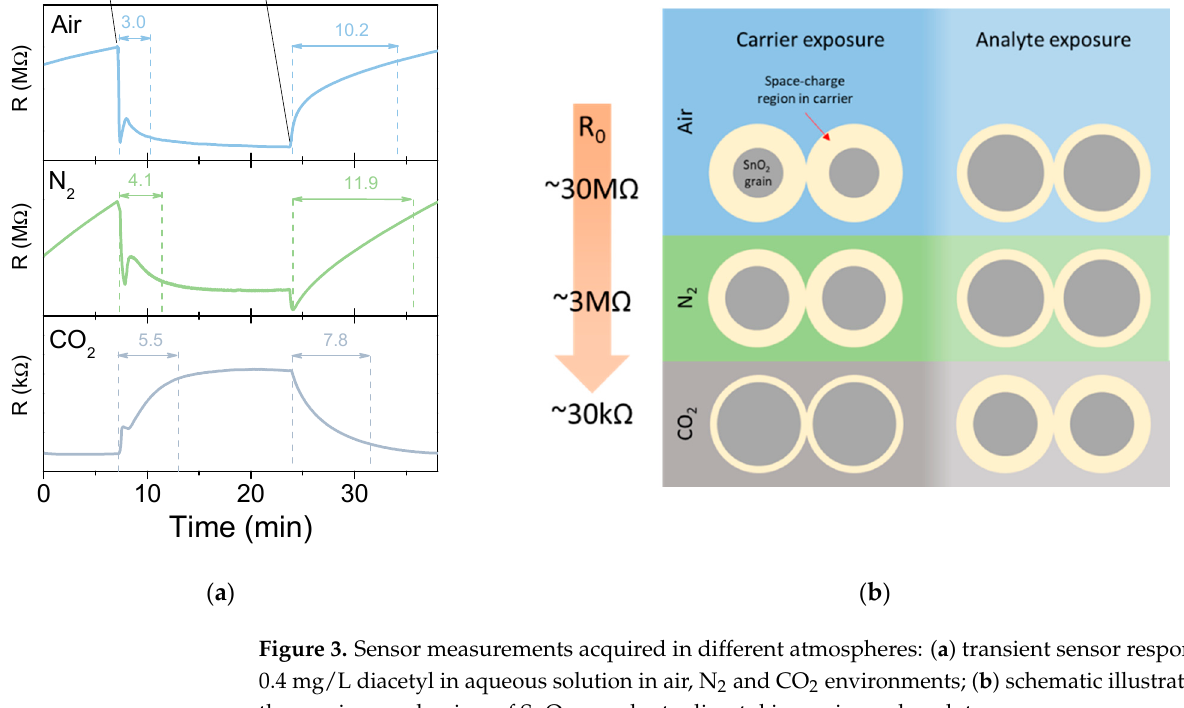
Figure 3. Sensor measurements acquired in different atmospheres: ( a ) transient sensor response of 0.4 mg/L diacetyl in aqueous solution in air, N 2 and CO 2 environments; ( b ) schematic illustration of the sensing mechanism of SnO 2 powder to diacetyl in carrier and analyte exposure.